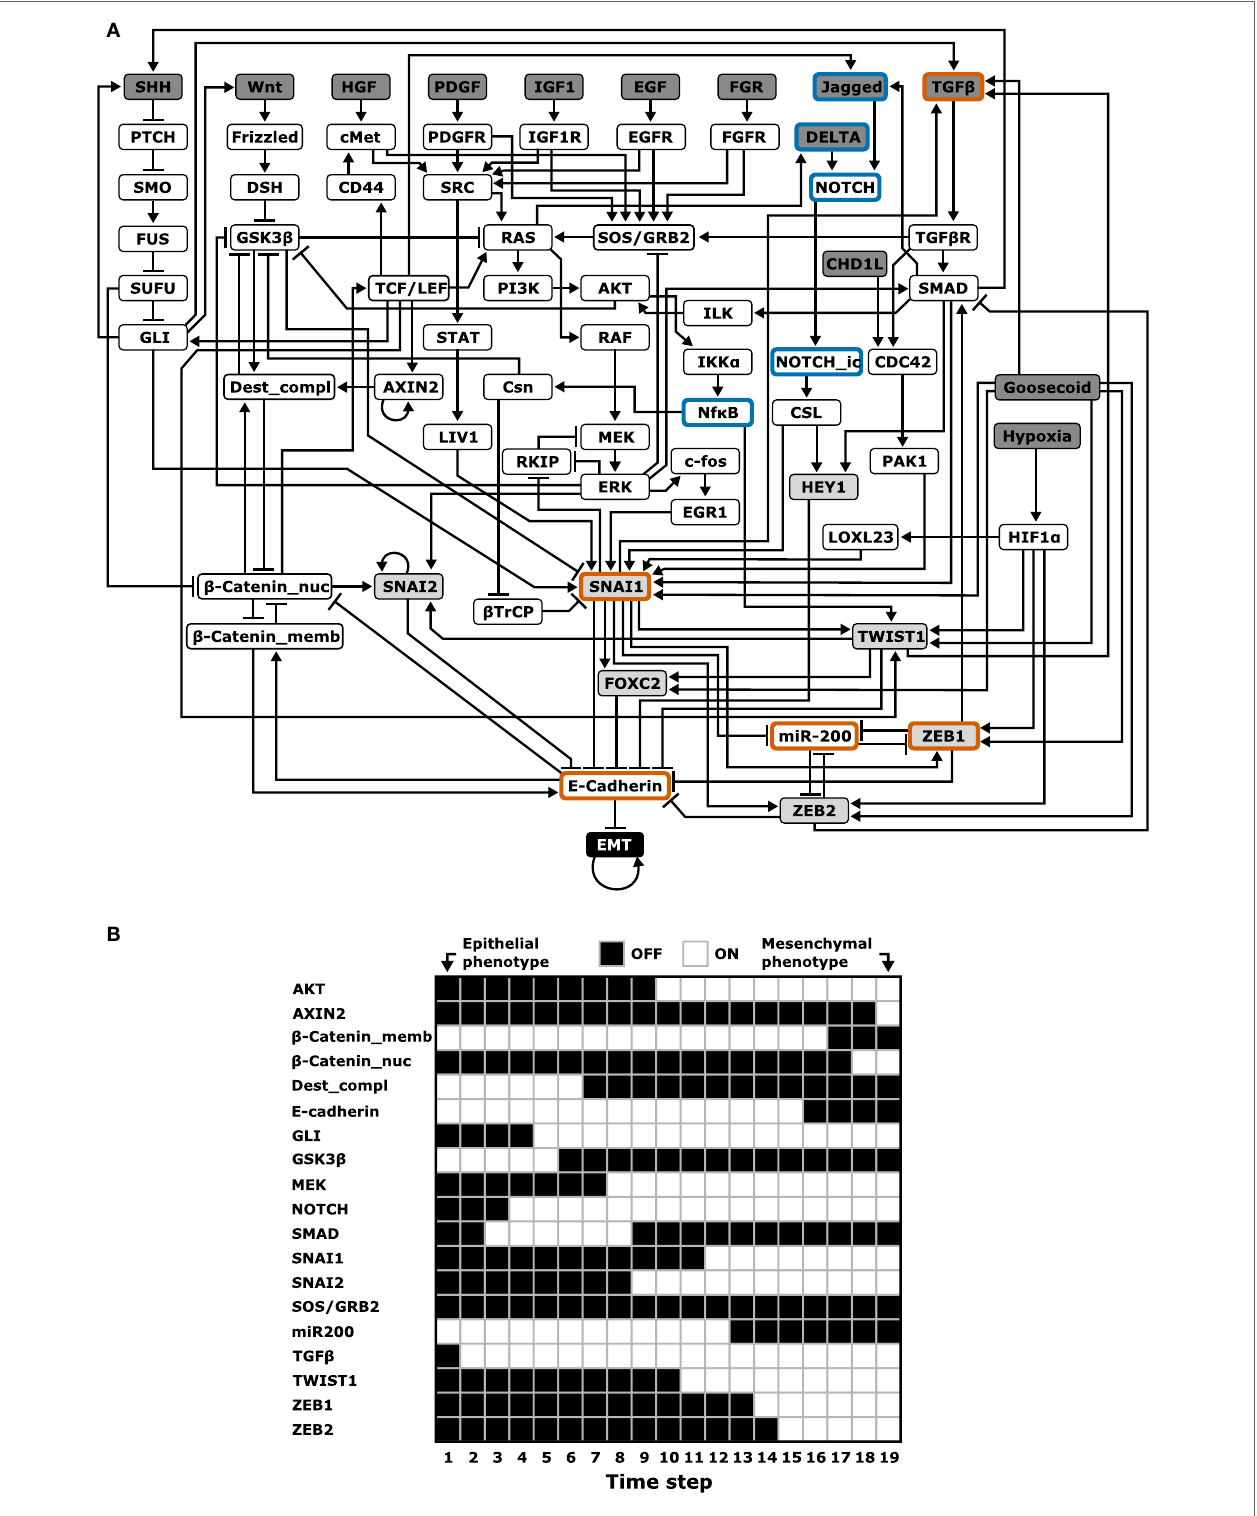
FiGURe 3 | Boolean modeling of epithelial–mesenchymal transition (EMT). (A) Boolean model with 70 nodes and 135 edges by Steinway et al. (57). The following network elements are highlighted: upstream regulators (dark gray), EMT transcription factors (light gray), and elements included in the cascading bistable switches and ternary chimera switch core regulatory models (orange border) or their extensions (blue border) [based on Ref. (57)]. (B) One of the probable transition paths from the epithelial to mesenchymal phenotype in a reduced, but functionally similar EMT model [cf. Figure 5A in Ref.